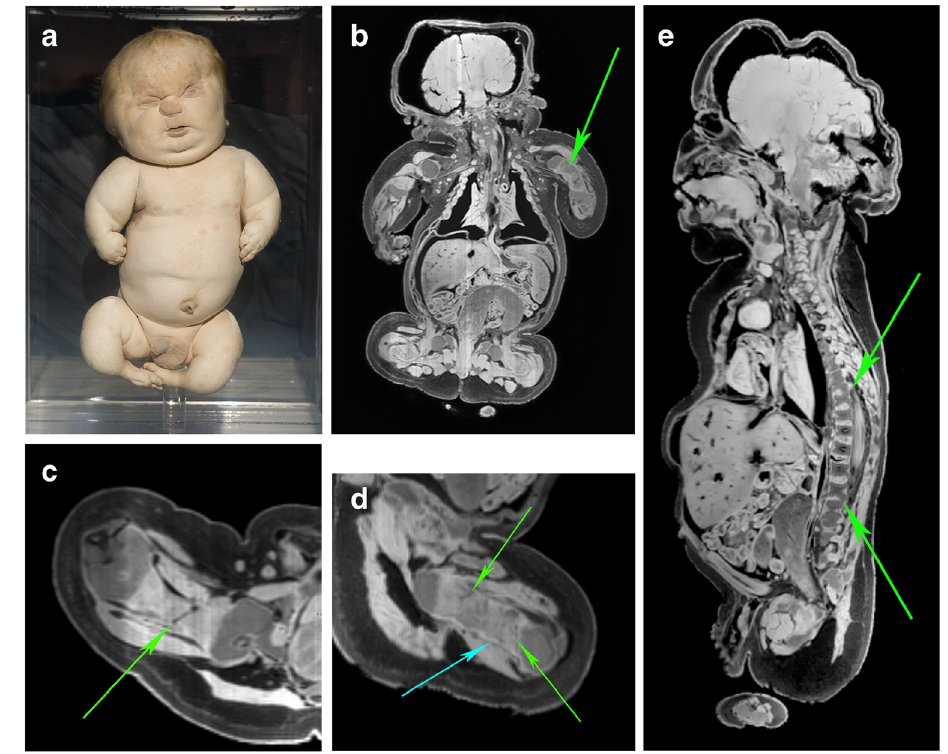
image of the broadened and shortened right femoral bone which showed a fracture ( green arrow ). d Transverse T1-weighted MR image of the severely shortened and aberrant left femoral bone which showed multiple fractures ( green arrows ) and irregular cortical bone ( turquoise arrow ). e Sagittal T1-weighted MR image showed multiple fractures in the verte- bral column ( green arrows ). Note the distorted calvarium due to limited mineralisation and the shrunken brain due to the formalin